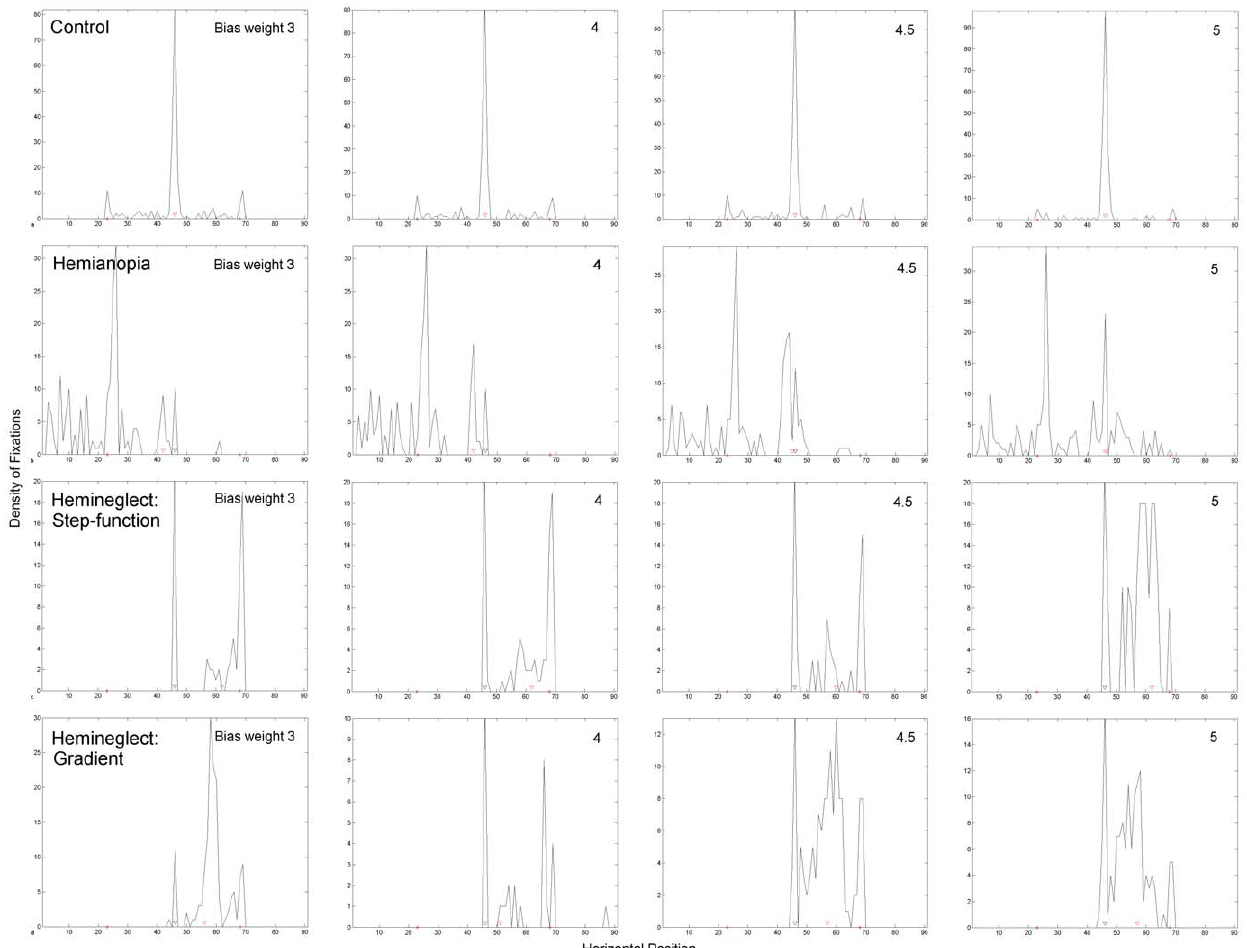
Figure 10. Fixation Density Plots from Multiple Scanpath Simulations. This shows the effect of lesion condition and bisection task bias on line scanning & bisection. Results come from 10 independent scanpath simulations for each condition. The density of fixations at each horizontal position across the scene is plotted in 1 u bins. Note that, in order to clearly show each plot, sub-figures are plotted to the scale dictated by the Y axis maximum and this varies between plots. The control condition is shown in row (a), V1 lesion in row (b), parietal step-function lesion model in row (c) and parietal gradient lesion model in row (d). As in figure 9, the bisection bias was systematically increased here such that it is set to 3 in the leftmost column, 4 in the second column, 4.5 in the third and 5 in the final column. Fixations that landed more than 1 u away from the line in the vertical direction are excluded. This only affected parietal lesion simulations where fixations were eliminated when they went off the line towards the edge of the scene. The number of simulations in which this occurred is given in table